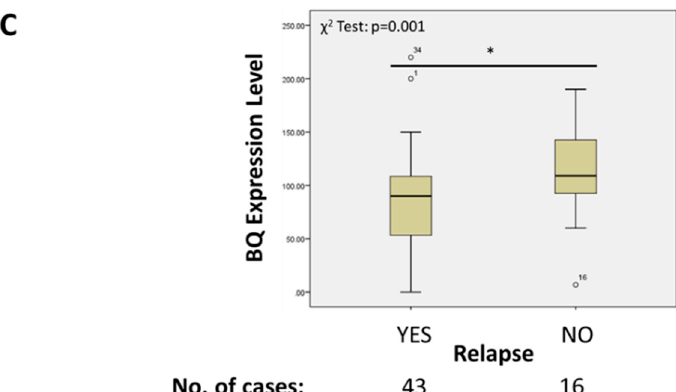
Figure 3. BQ is associated with chemoresistance of breast cancer. ( A ) Expression of NCOR2 and BQ in MCF-7, MCF-7 EpiR, and MCF-7 TaxR cells were detected by Western blot. β -Actin served as the loading control (left panel). The intensities of NCOR2 and BQ bands were quantified by Image J analysis software which represents their relative protein expressions. Ratios of relative BQ to NCOR2 expression were calculated (right panel). Data presented as means ± SD, * p < 0.05; ** p < 0.01. (N = 3) ( B ) Immunohistochemical (IHC) staining of BQ in primary breast cancer samples in tissue microarray. Representative images of low or high BQ nuclear expression were shown. ( C ) Nuclear BQ expression score was associated with relapse status (Yes for with relapse; No for without relapse) as demonstrated with Mann–Whitney test in primary breast cancer samples; * p = 0.018. Nuclear BQ expression score were dichotomized at the median value and Chi square test performed for association with relapse status (Chi-square test p = 0.001).